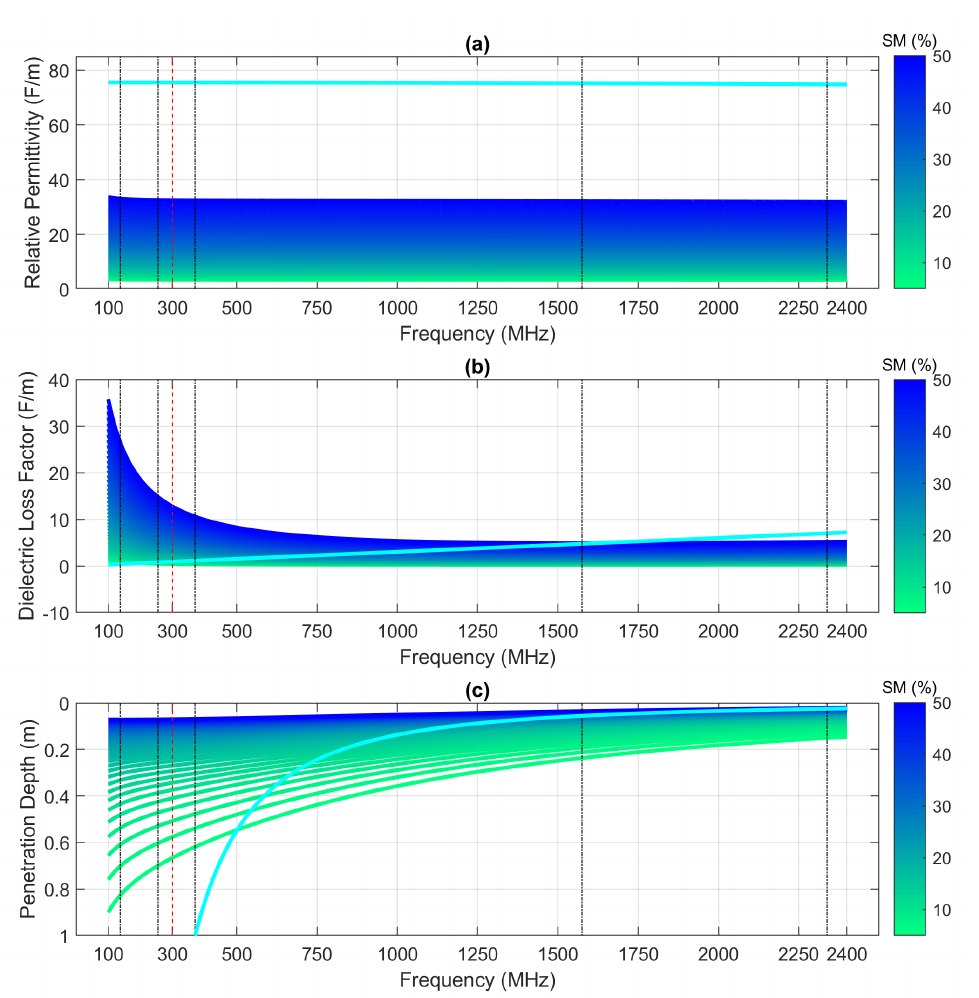
Figure 4. Behavior of ( a ) real and ( b ) imaginary dielectric constant for multiple soil moisture values as a function of frequency in addition to ( c ) penetration depth information from Equation (6). The color gradient shows the dielectric constant for soil moisture between 5% and 50%, and the cyan line shows the dielectric constant of water for the given frequency range. The black dashed lines show the position of the commonly referenced SoOp-R sources, while the red dashed line shows the lower validation region of the Mironov dielectric